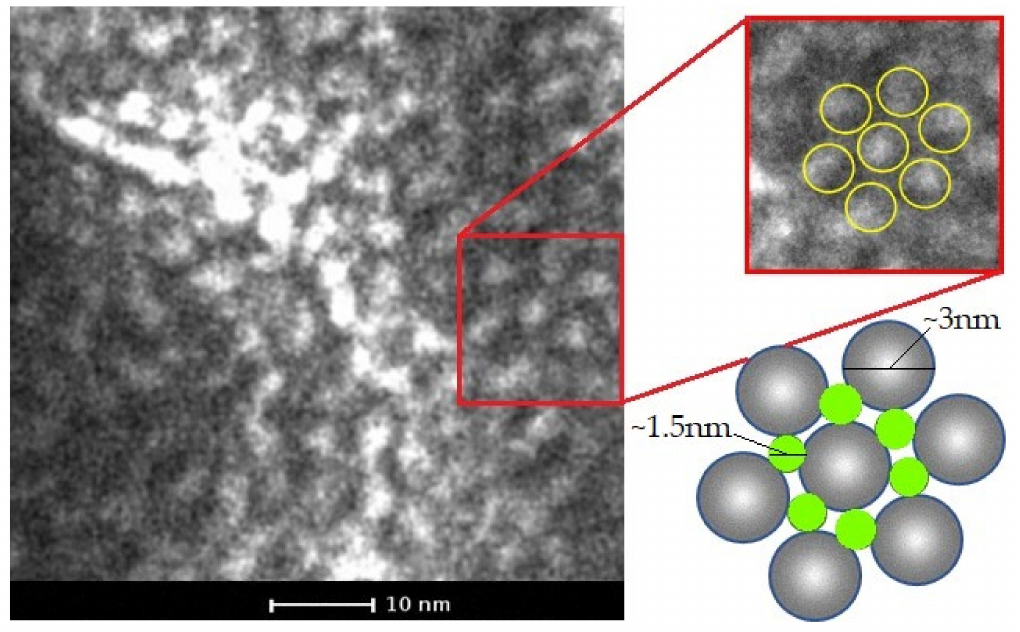
Figure 2. Transmission electron microscopy (TEM) micrography of S-layer protein (SLP). Zoom and representation of p6